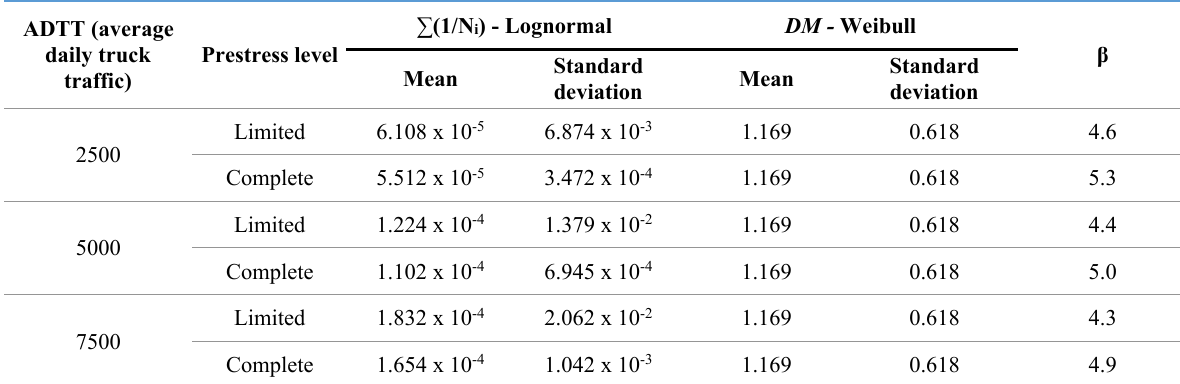
Table 9. Moments for dependent variables and reliability indexes (β) for stirrups (interior girder) for design service life of 50